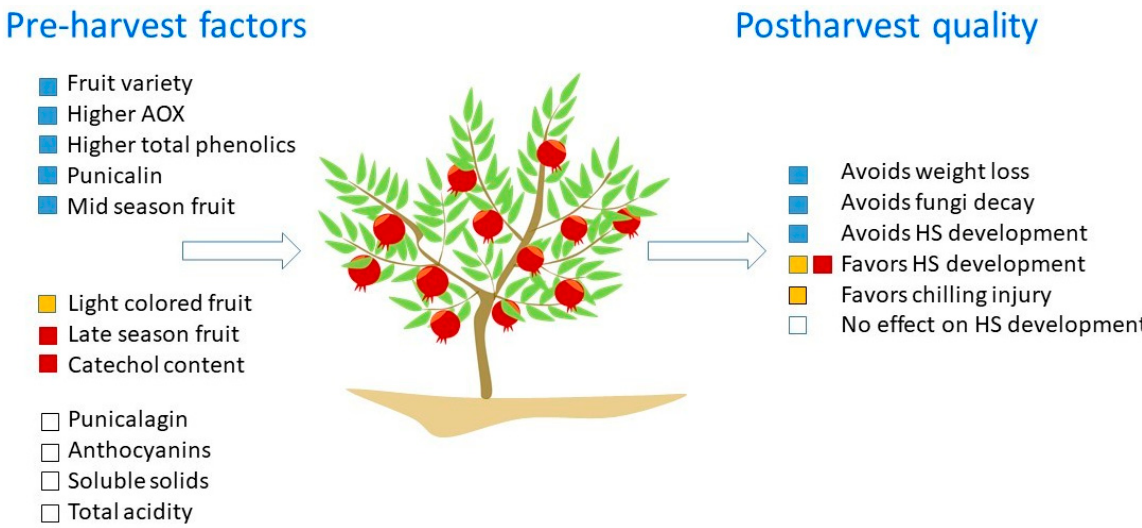
Figure 4. Integral model linking pre-harvest factors and its effects on HS development during postharvest storage. This integrative approach based on reported studied in the literature (see Section 4.1) can be used as a reference for identifying and introducing future studies on pre-harvest factors and also dissect their effects on different pomegranate fruit quality attributes and physiological disorders besides HS (e.g., chilling injury